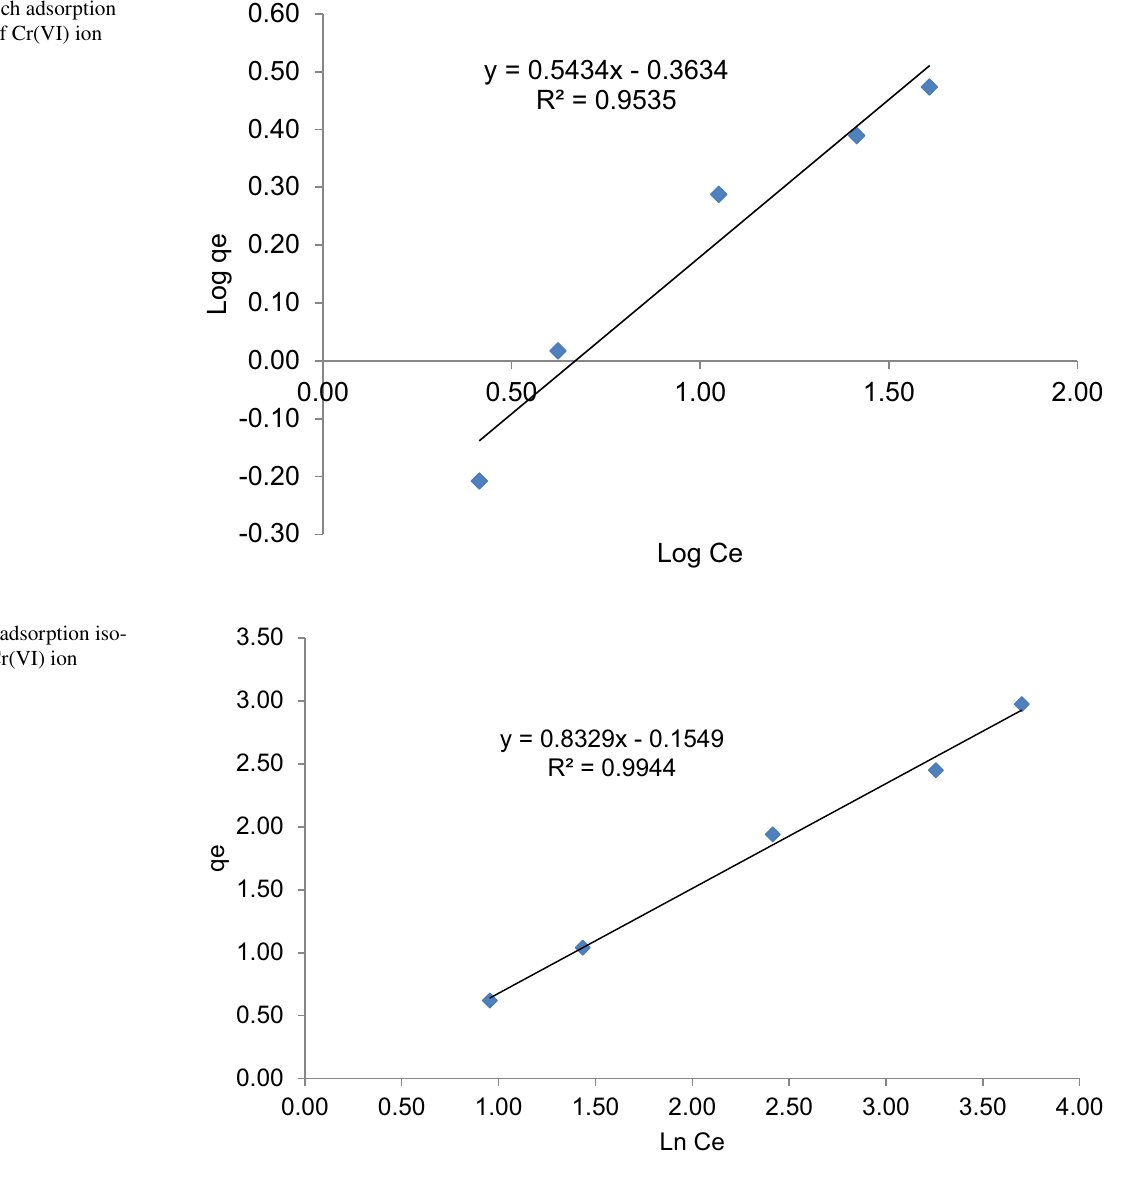
y = 0.5434x - 0.3634 R² = 0.9535